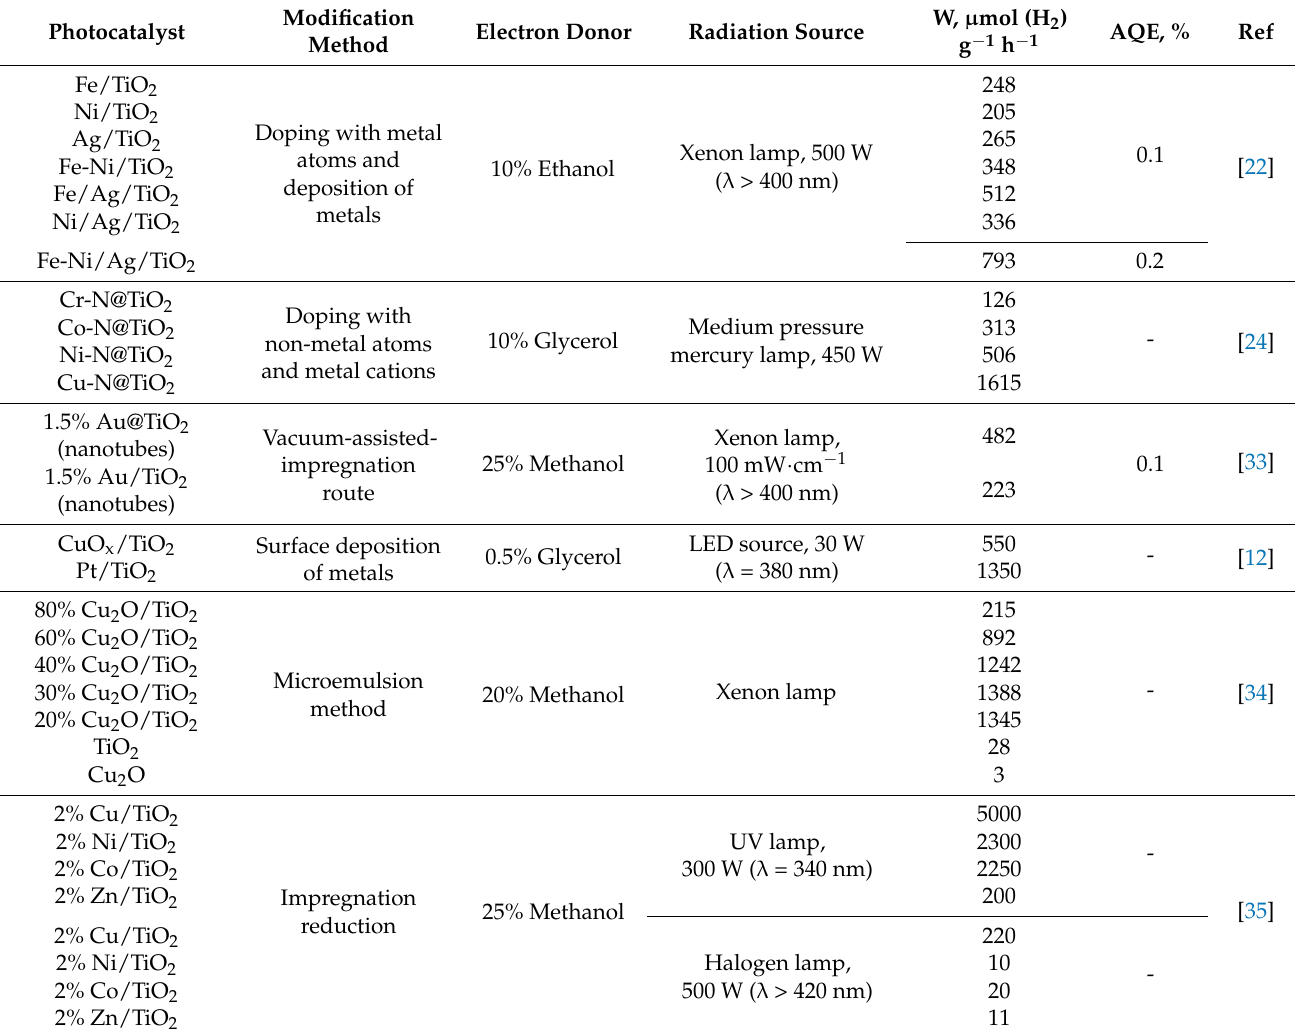
Table 4. Activity of photocatalysts based on TiO 2 in the formation of H 2 from aqueous solutions of